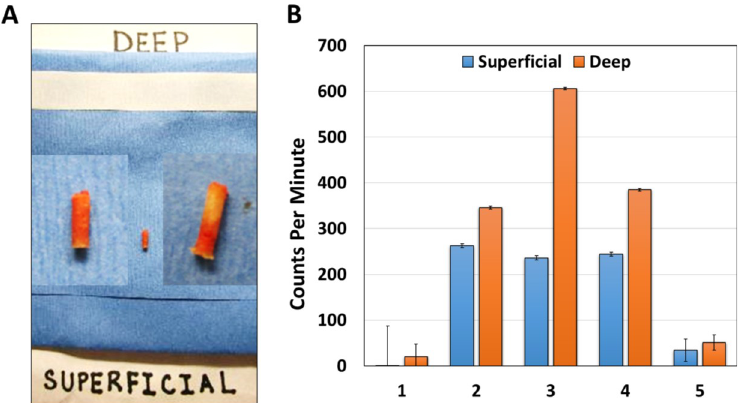
Fig 6. A. Examples of CT guided bone biopsy cores divided into superficial and deep sections for gamma emission analysis. B. Bar graph of superficial vs. deep bone gamma emission from 5 patients treated with radium-223 and collected after 3 doses. Error bars represent standard error with triplicate replicate